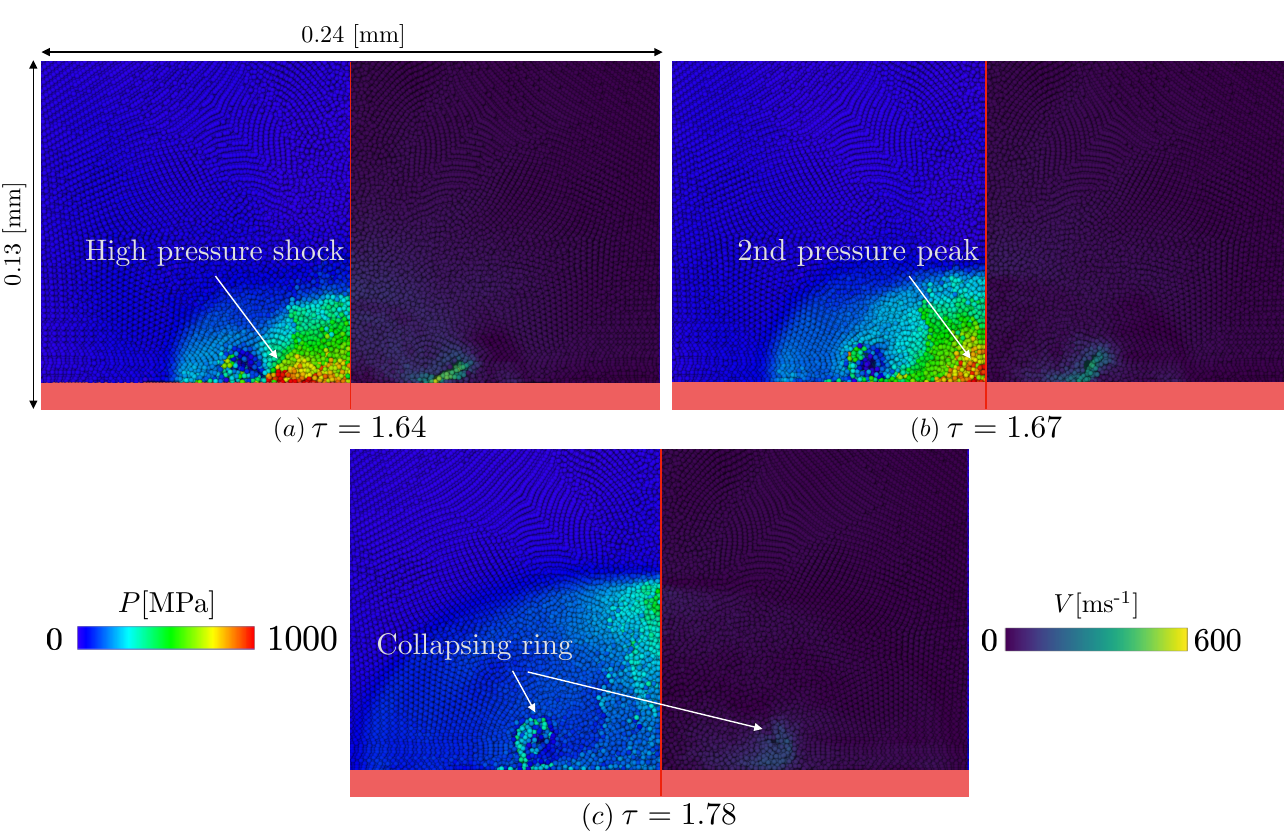
Figure 8. Pressure and velocity field in the domain represented in Figure 1 for different collapse snapshots in Region III ( dL / R 0 = 133, γ = 0.6 & P ∞ = 50 [MPa]): ( a ) Inner high pressure shock generation. ( b ) Second pressure peak generated by the travelling inner shock. ( c ) Collapsing ring expansion.